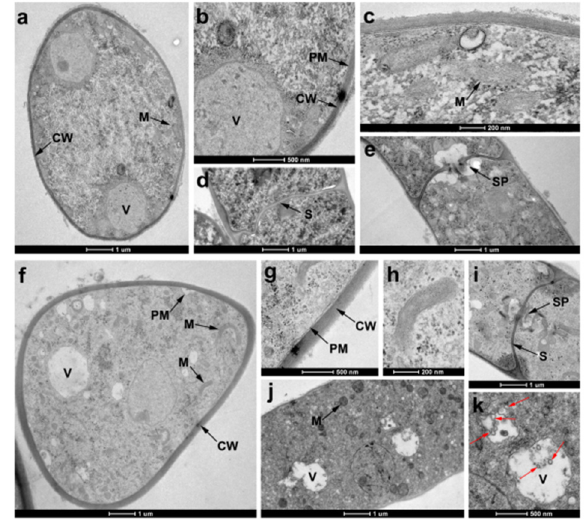
Figure 5. SEM of R. solani hyphae treated with 0 ( a , b ) or 1 μ g/mL 55 ( c , d ) .